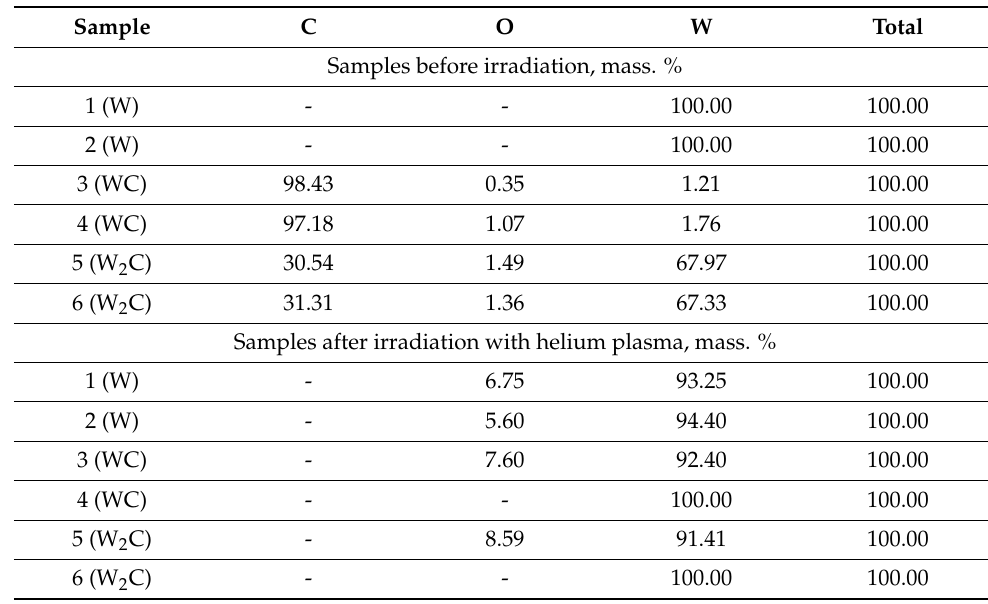
Table 3. Results of EDS analysis of the surface of tungsten